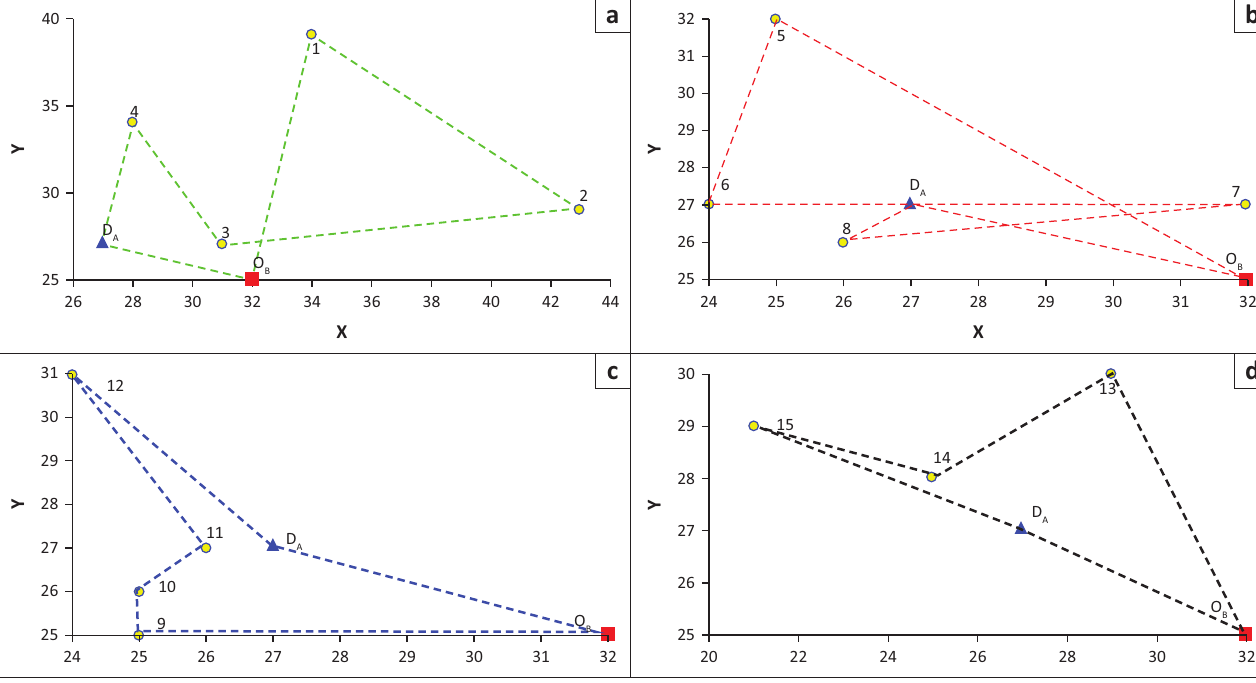
FIGURE 6: Current routes served by company B for the real problem: (a) Route 1, (b) Route 2, (c) Route 3, (d) Route 4. TABLE 2: Distances between all locations for the real problem ( C